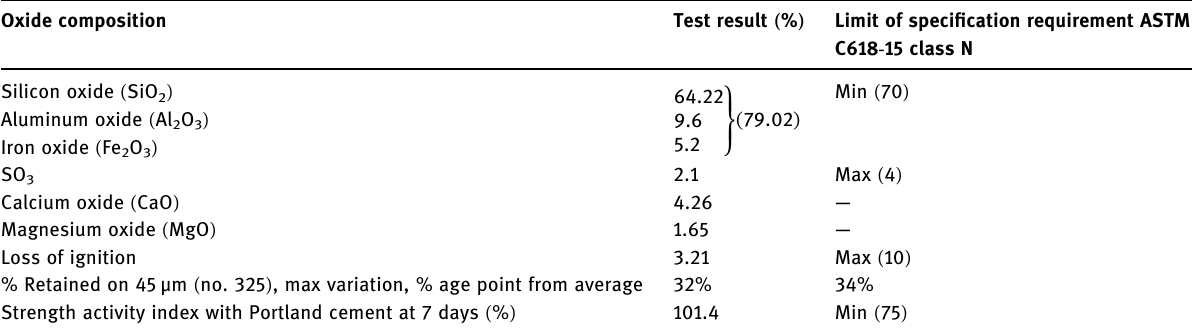
Table 2: Physical and chemical properties of glass powder Oxide composition